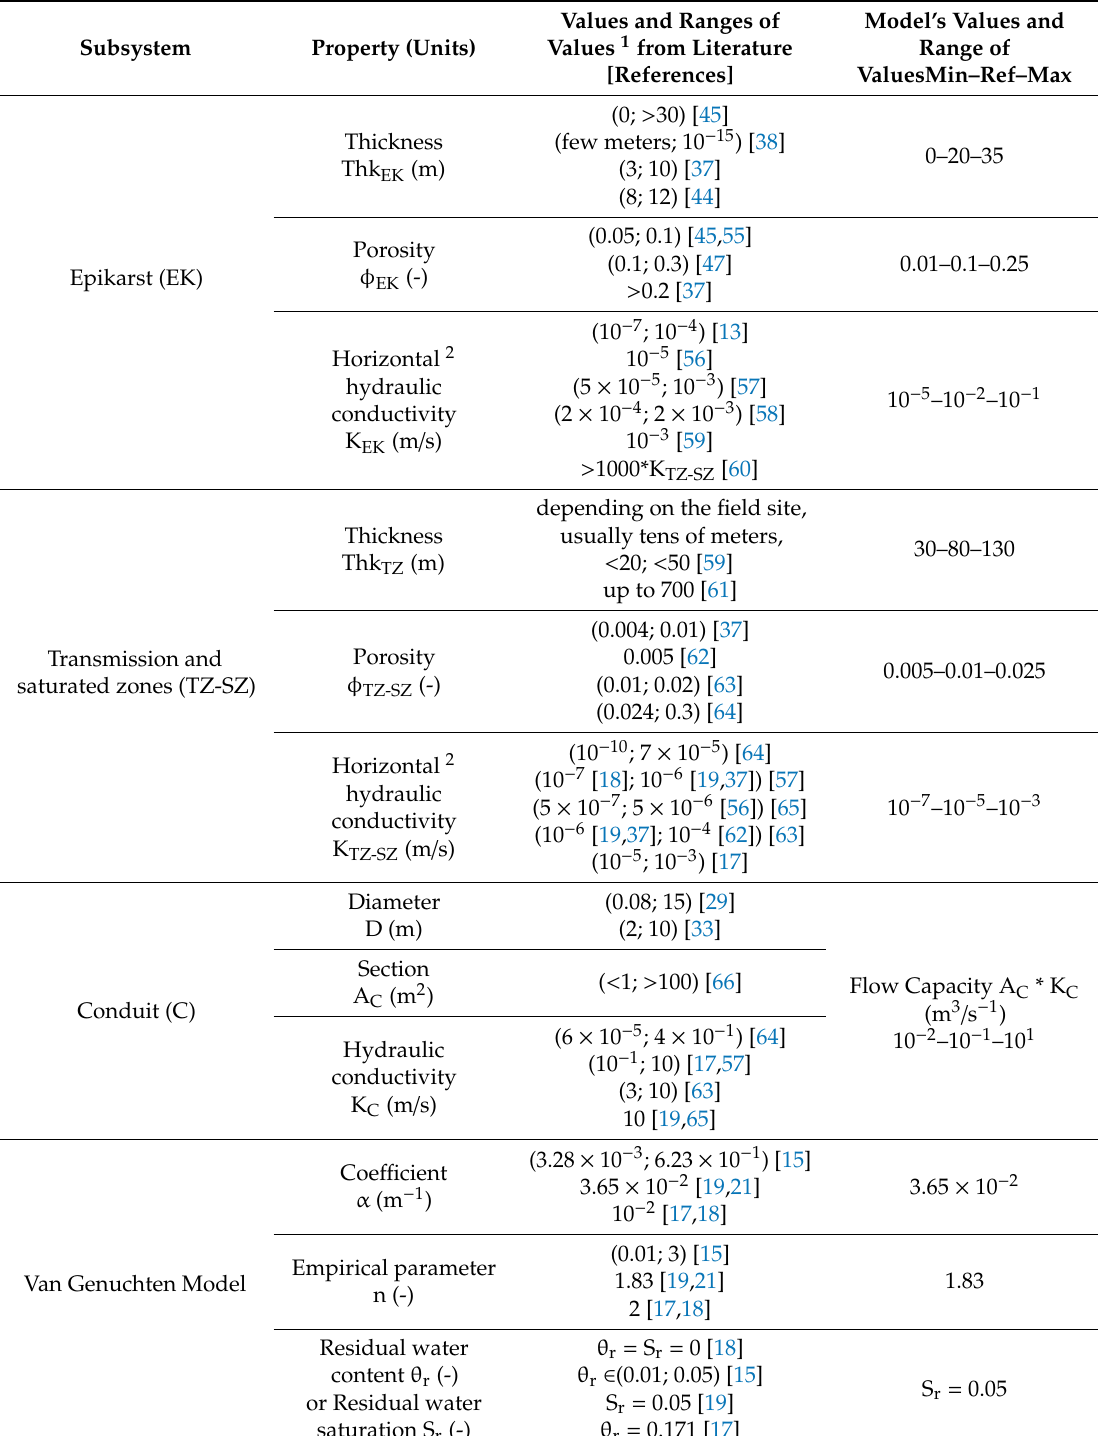
Table 1. Value ranges for the properties of karst systems and karst modeling reported in the literature and model